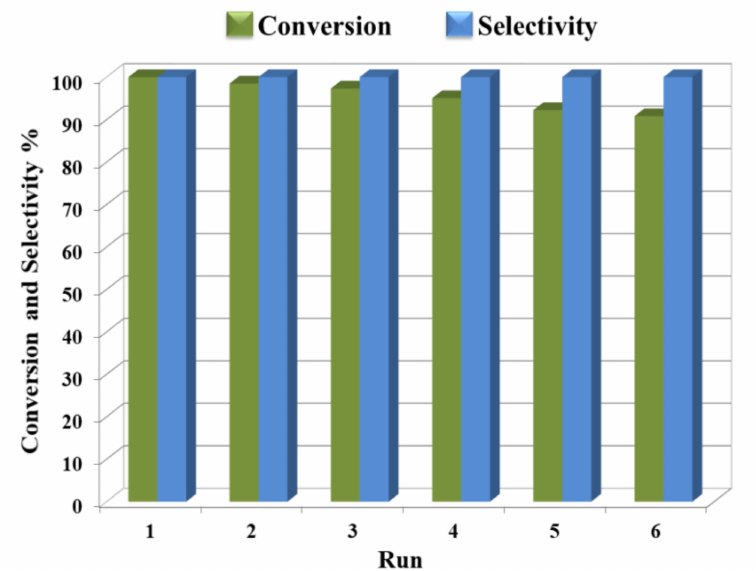
Figure 12. Reusability data of (1%) ZnO–MnCO 3 /(1%-NDG) catalyst for aerial dehydrogenation of BOH. Conditions: BOH (2.0 mmole), toluene (15 mL), O 2 flow rate (20 mL/min), catalyst amount (0.30 g), operation temperature (100 ◦ C), and time (5